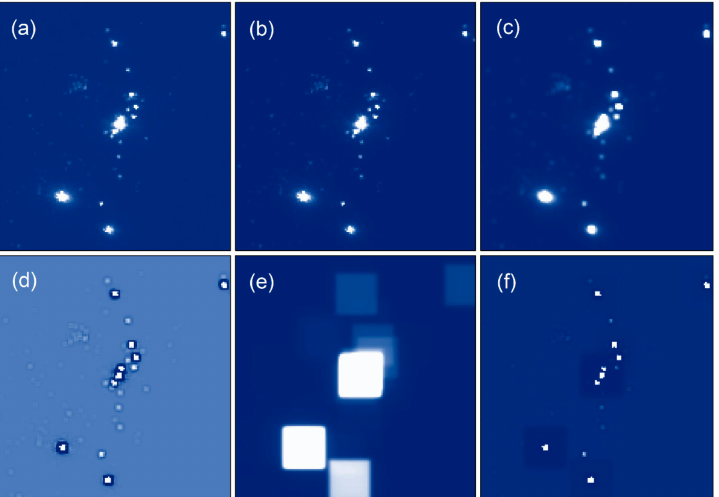
Figure 4. Data preprocessing: ( a ) original image; ( b ) negative adjustment image; ( c ) local Sigma filtered image, the window size is 3 × 3, Sigma factor is 4; ( d ) Hp image, convolution kernel is 3 × 3; ( e ) Lp image, convolution kernel is 27 × 27; ( f ) the difference between Hp image and Lp image. The parameters used in the above process are obtained through estimation and trial and error, and remain unchanged for all NTL images